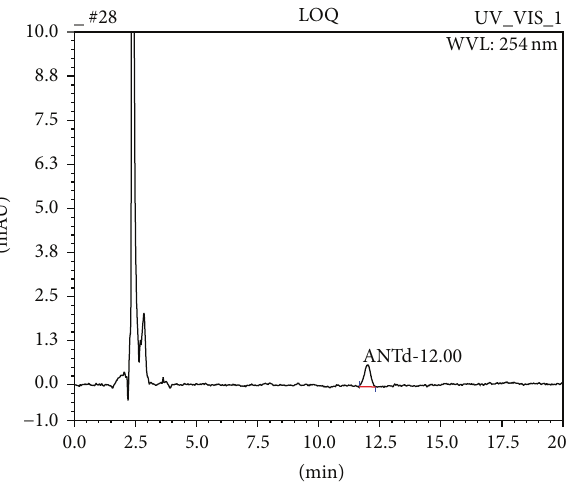
Figure 8: LOQ solution (0.1554 𝜇